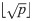
Error rate estimates for the binary null case study (balanced).Shown are different error rate estimates for the setting with two response classes of equal size and without any predictors with effect. The error rate was estimated through the test error, the OOB error, the stratified OOB error, the CV error, and the stratified CV error for settings with different sample sizes, n, and numbers of predictors, p. The mean error rate over 500 repetitions was obtained for a range of mtry values. The vertical grey dashed line in each plot indicates the most commonly used default choice for mtry in classification tasks, that is ⌊p⌋.